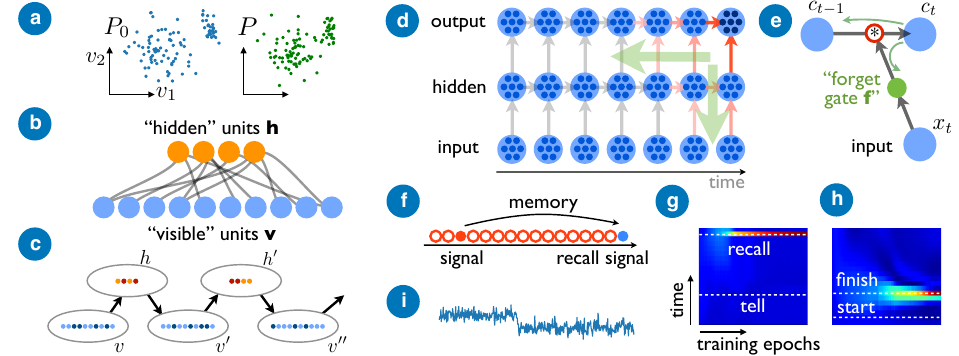
Figure 6: (a) The goal of a Boltzmann machine is to learn to sample from an ( v ) . (b) A restricted approximation P to an observed probability distribution P 0 Boltzmann machine, with connections between visible and hidden units. (c) During training, starting from an observed sample v , a Monte Carlo Markov chain is produced according to the current statistics of the Boltzmann machine. (d) Structure of a recurrent neural network, with feedforward connections in time. (e) A “forget gate” neuron as part of a long short-term memory (LSTM) network. (f) A typical challenge requiring long memory times. (g) A signal triggers the recall of a number presented earlier to the network. The training progress is shown here. (h) A network learns to count down from an arbitrary number (input at “start”). (i) A typical application of recurrent networks in physics: analyzing fluctuating measurement time